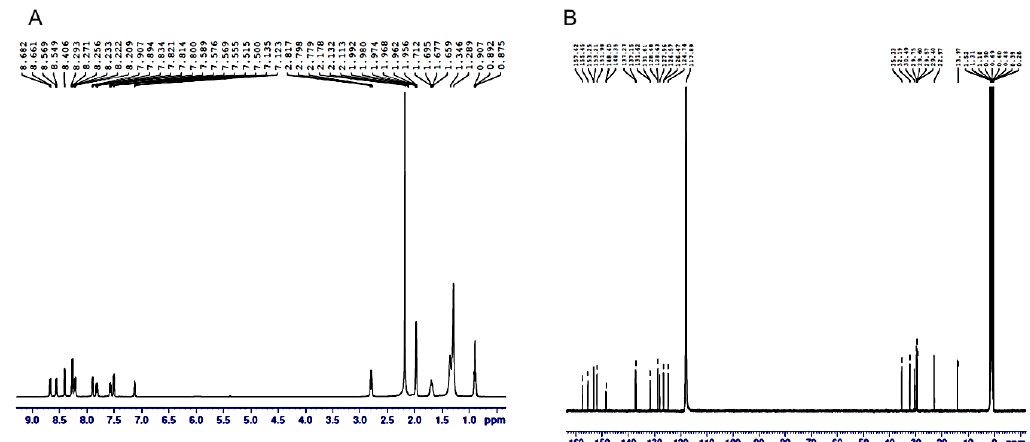
Figure 9. The NMR spectra of RC-7. ( A ). 1 H-NMR spectrum. ( B ), 13 C-NMR spectrum.